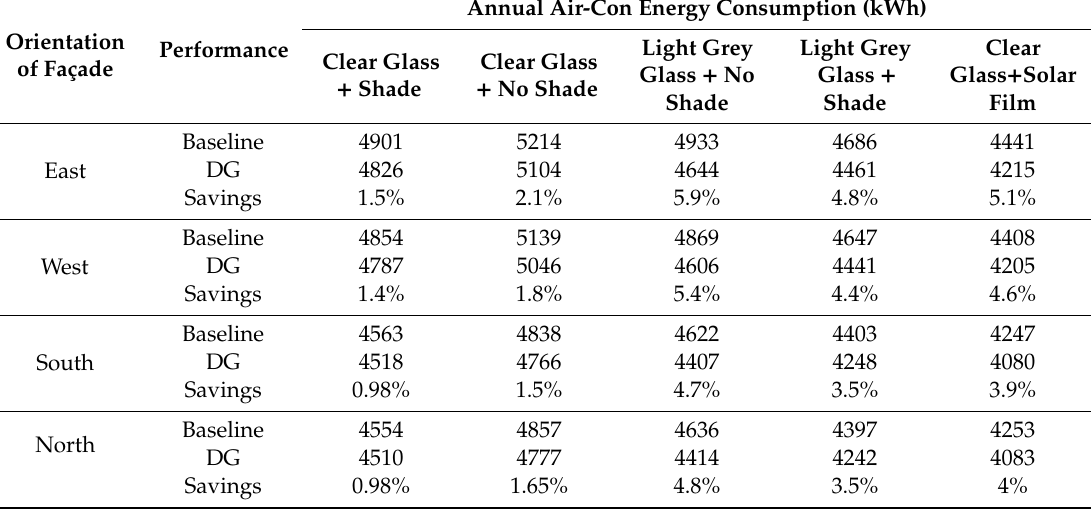
Table 7. Annual energy savings from reduced air-con power consumption after retrofit double-glazing installation, derived from energy modeling